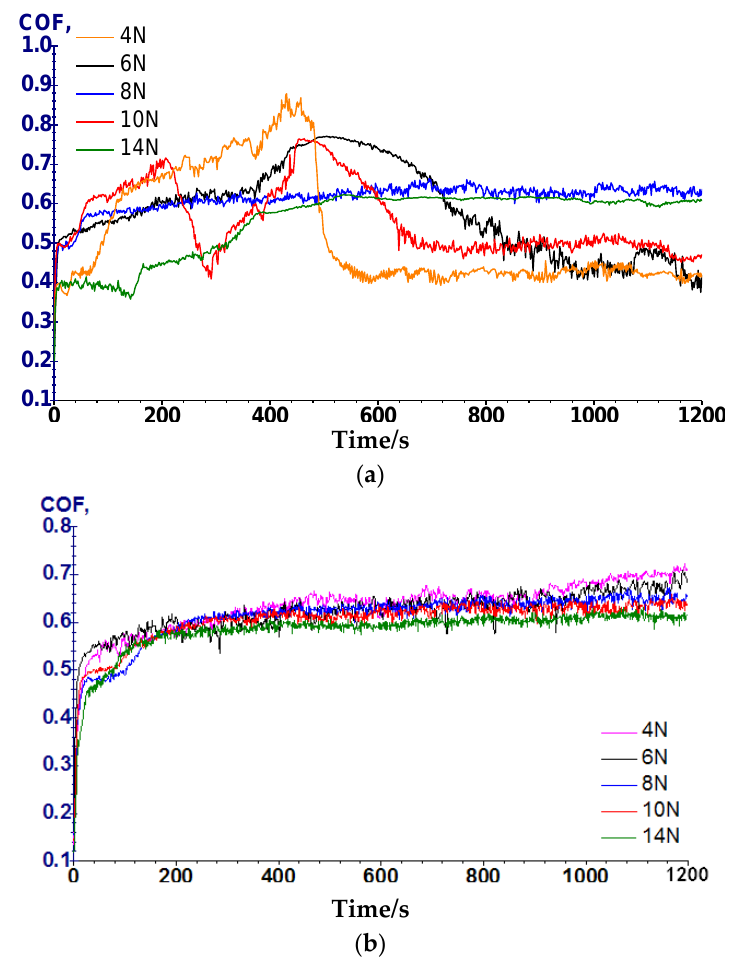
Figure 6. Friction coefficient curves of the two groups of samples with different porosities under different loads: ( a ) friction coefficient curves with the porosity ε = ~24%–26%; and ( b ) Friction coefficient curves with the porosity ε = ~38%–42%.